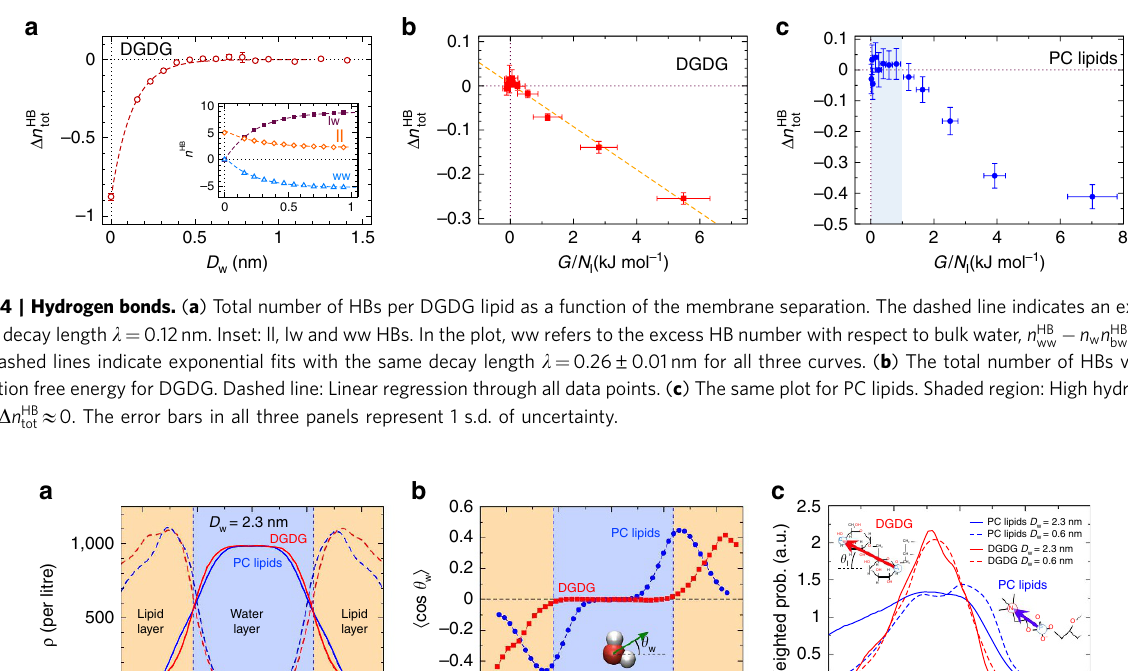
Figure 5 | Origin of the long-range repulsion. ( a ) Density profiles of water and lipids in hydrated DGDG and PC lipid membranes at a large separation, D w ¼ 2.3nm. Vertical lines indicate the membrane surfaces at ± D w /2. ( b ) Water orientation profiles h cos y w i at the same separation. Inset: Definition of the water dipole angle y w . ( c ) Distributions of DGDG and PC lipid headgroup orientations with respect to the membrane normal for large ( D w ¼ 2.3nm, solid lines) and small ( D w ¼ 0.6nm, dashed lines) separations. Inset: Definition of the headgroup vectors.